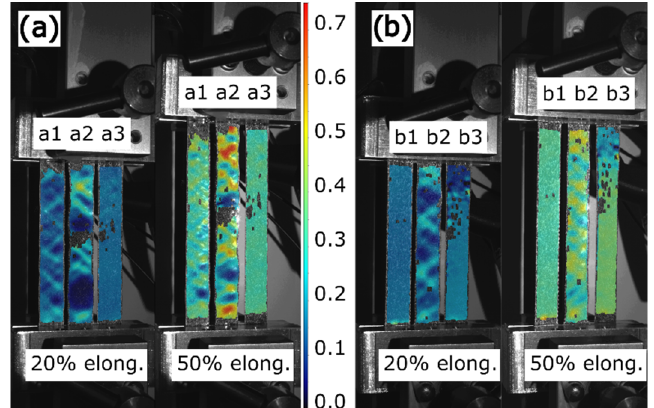
Figure 10. DIC y ‐ axial Hencky strain results of 3D ‐ printed samples in 20% and 50% elongations: ( a ) the a1 sample with 2 thin CFCs, the a2 sample with 3 thin CFCs, and the a3 sample with 1 thin CFC; ( b ) the b1 sample without CFCs, the b2 sample with 1 thick CFC, and the b3 sample with 1 thin CFC. The scale bar shows the level of local deformations compared to the initial undeformed phase of the samples.